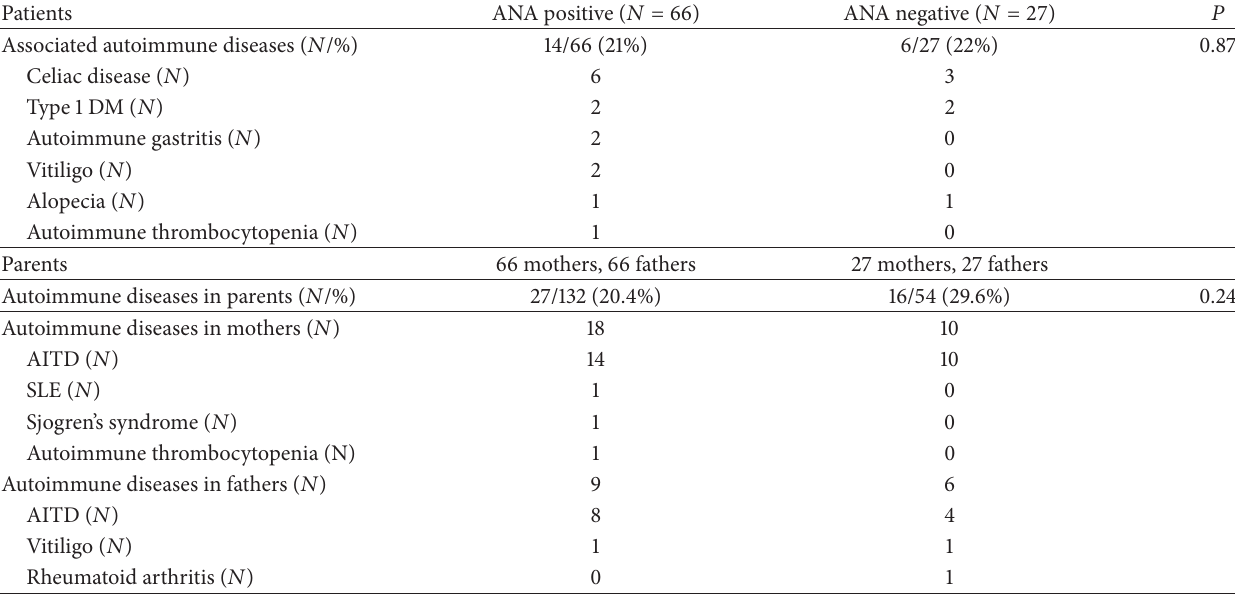
Table 2: Associated autoimmune diseases in ANA-positive and ANA-negative children with AITD and in their parents. Patients